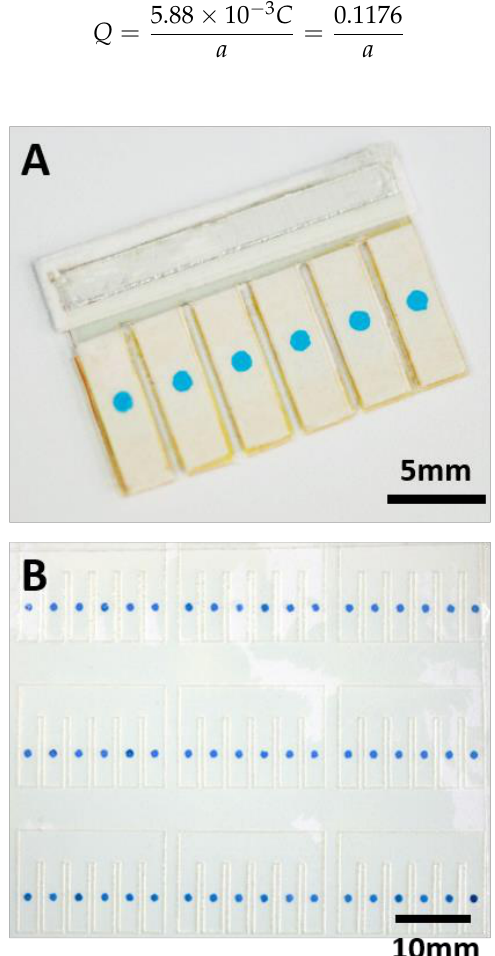
Figure 2. ( A ) Photograph of the electrochromic sensing array for LA detection; ( B ) Photograph of the PB spots simultaneously electrodeposited on an ITO film substrate. The electrochromic array contains 54 PB spots, which can be further cut and used to fabricate 9 sensing devices.